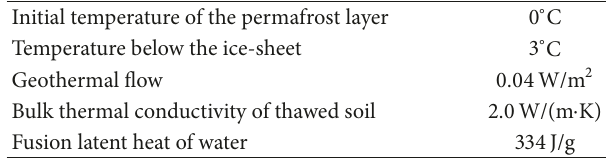
Table4:Parametersusedforthecalculationofpermafrostthickness and depth, after the analytical equation of Lunardini